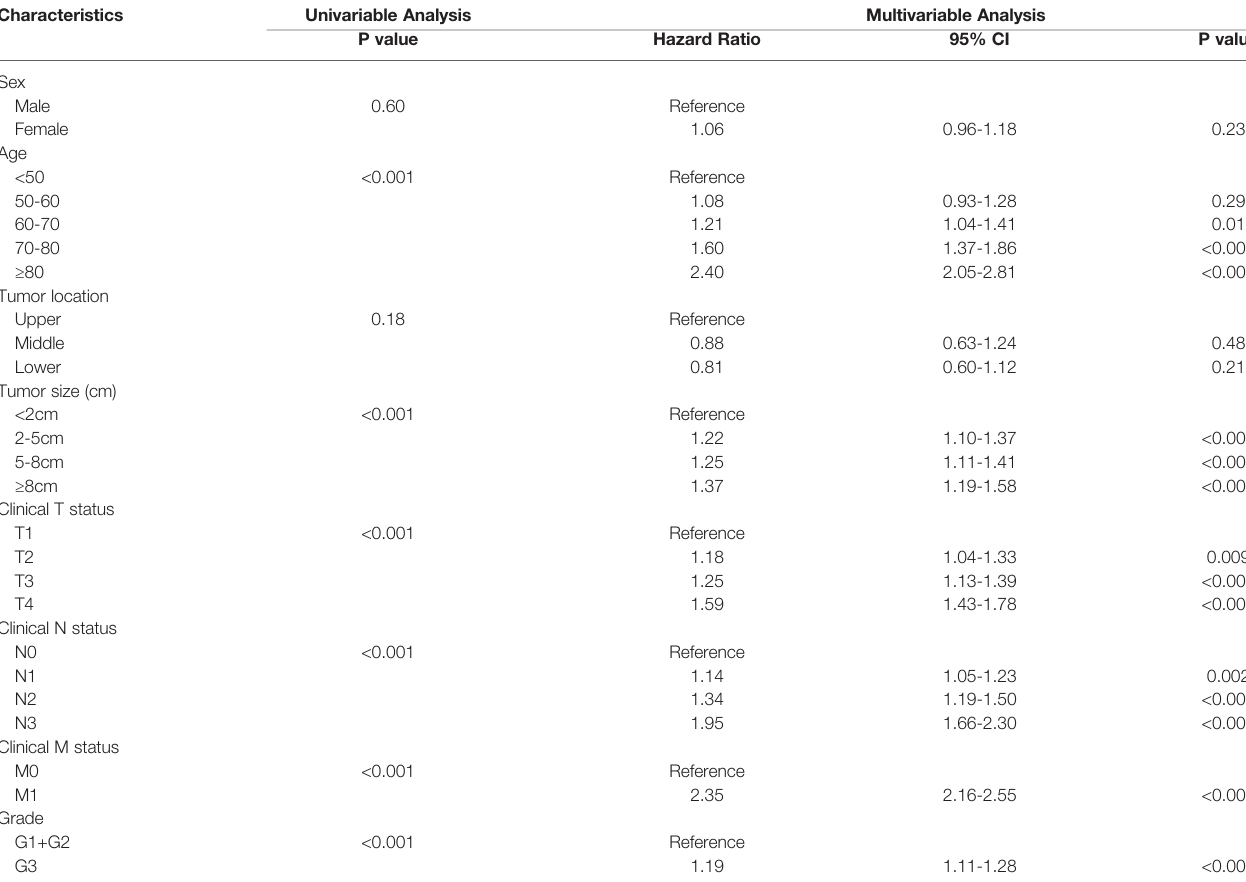
TABLE 2 | Results of univariable and multivariate Cox proportional hazards regression analysis for overall survival in the training cohort. Characteristics